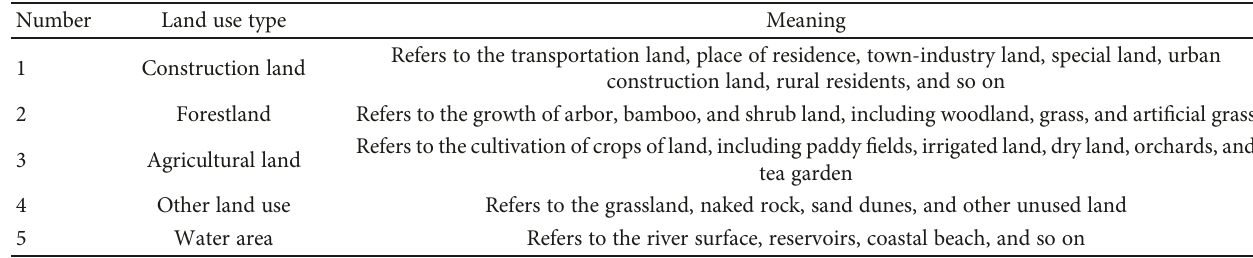
Table 3: Land use type classi fi cation of Jinzhou District in Dalian.